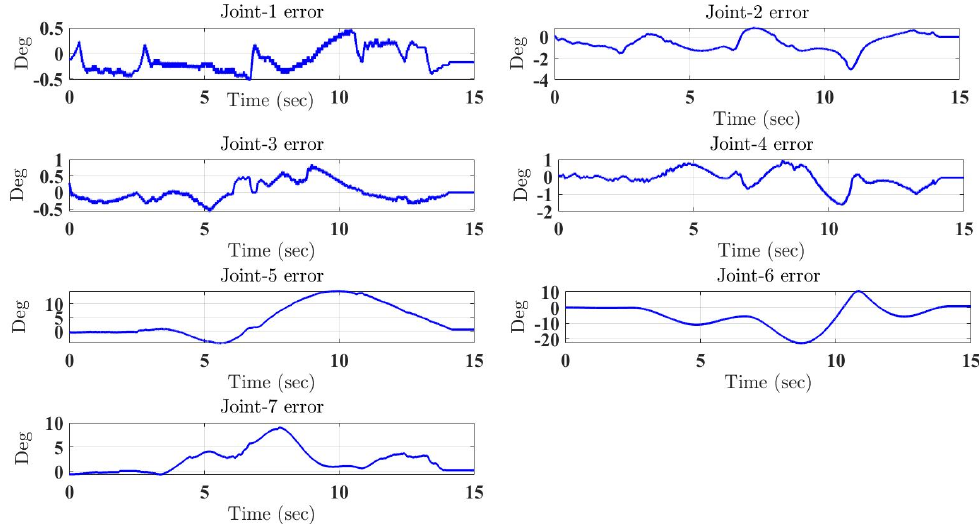
Figure 6. SRex’s trajectory tracking in joint space under the proposed controller (corresponding to Cartesian Trajectory given in Figure 4).